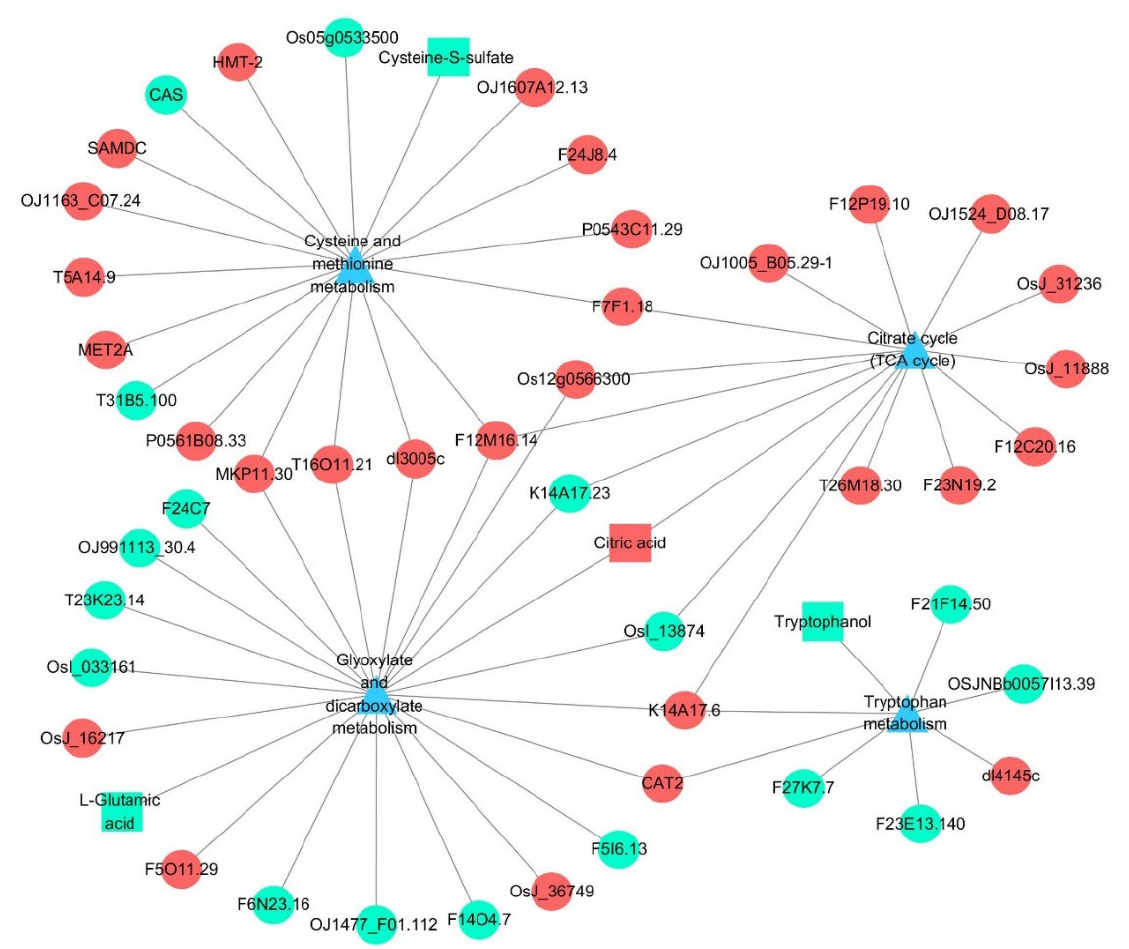
Figure 9. Integrated analysis of regulated pathways identified by transcriptomic and metabolomic analyses. Triangles, squares, and circles represent pathways, differential metabolites, and DEGs, respectively. For DEGs and differential metabolites, red and green indicate the upregulated and downregulated factors, respectively.